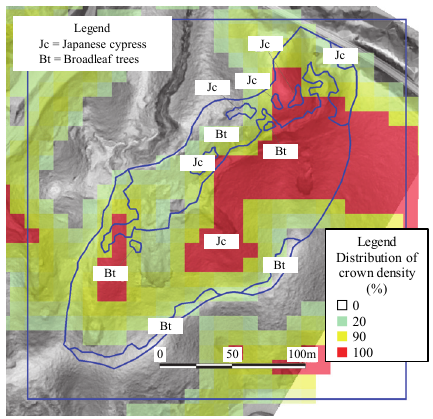
Figure 7. Distribution of crown density ( CR ) in the watershed